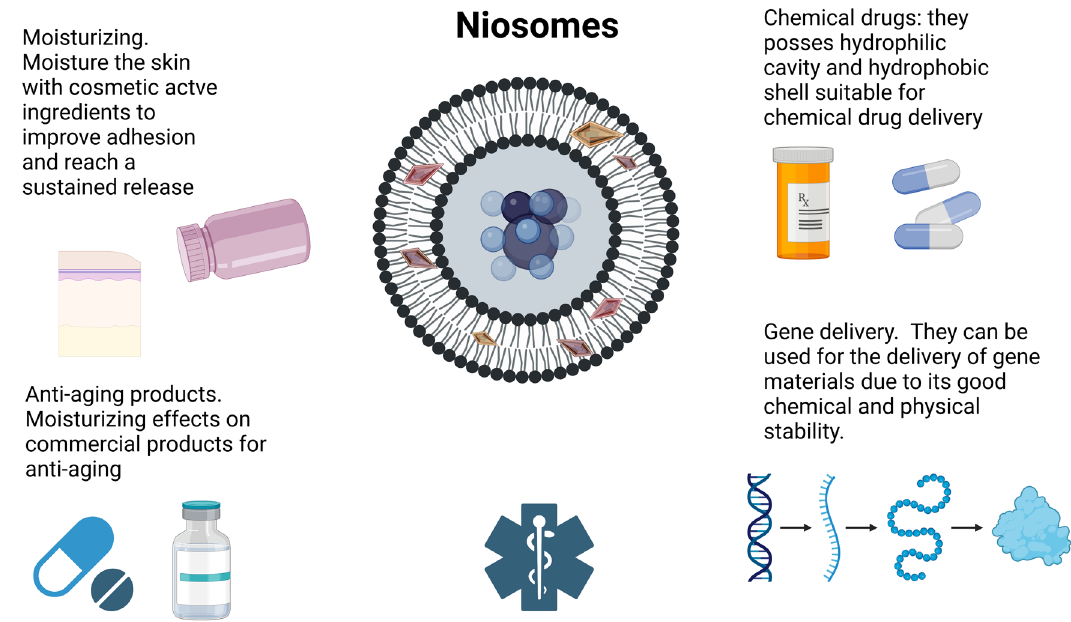
Figure 9: Niosomes applications. Created with